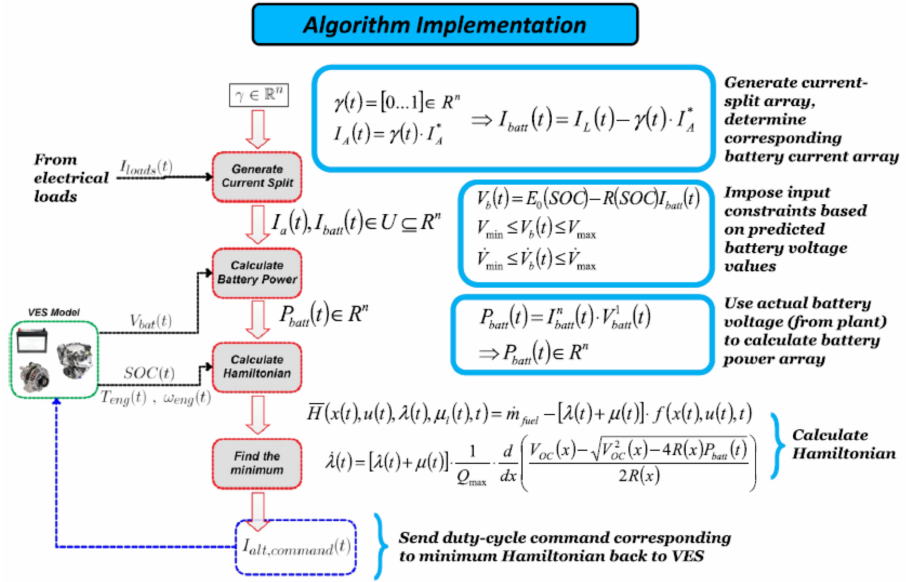
Figure 2. Block diagram of PMP control algorithm [13].